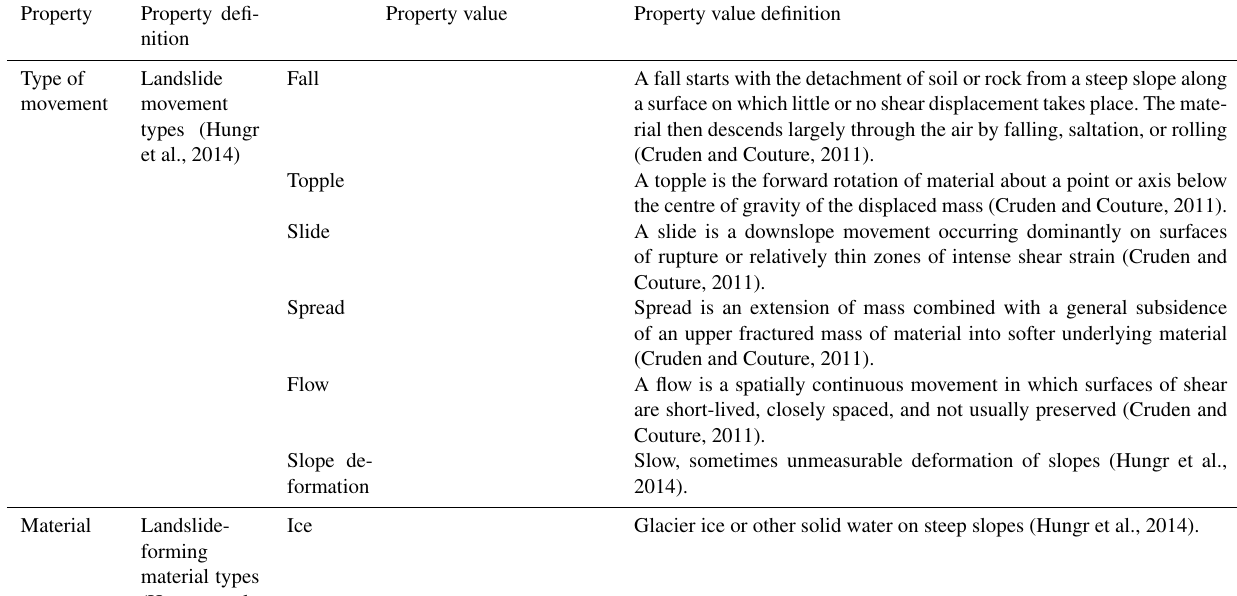
Table B1. Properties used for the definition of the Aristotelian taxonomy of